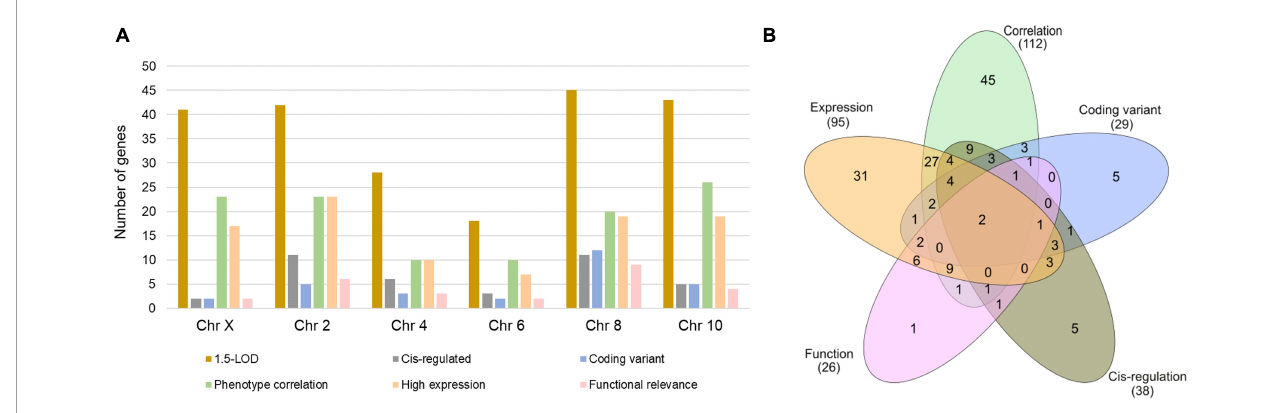
FIGURE2 Number of genes within 1.5-LOD interval across the significant and suggestive QTLs. (A ) Number of genes in each category for each indicated chromosome. (B) Number of exclusive and shared genes across five selection criteria .